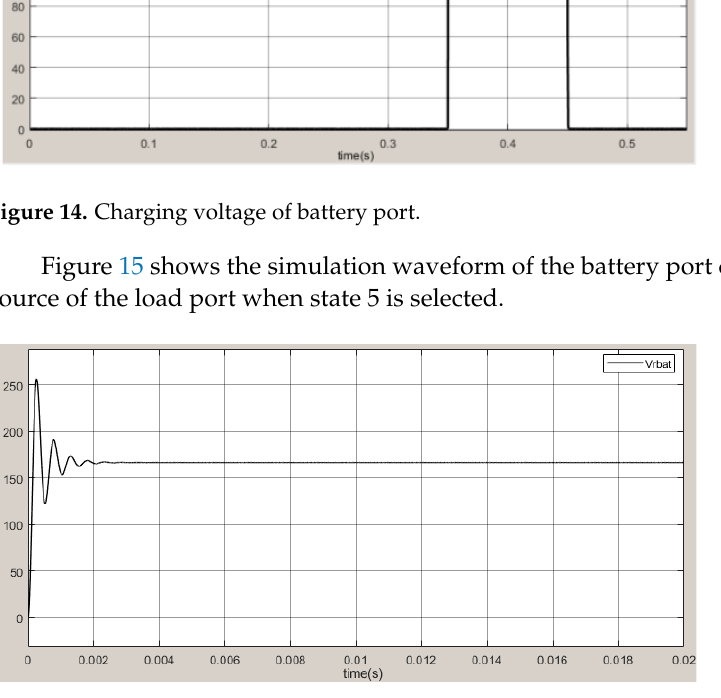
Figure 15. Charging voltage of battery port in feedback state.